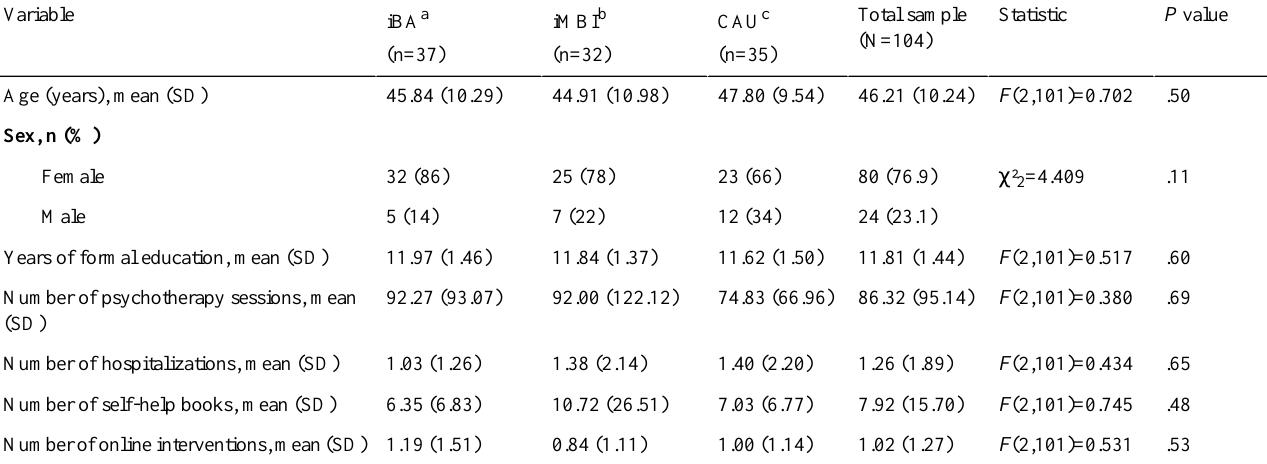
Table 1. Baseline demographics.